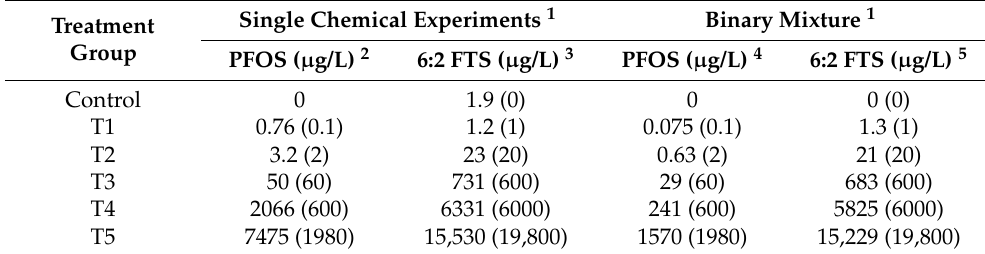
Table 1. Dose regimens for component experiments and binary mixture